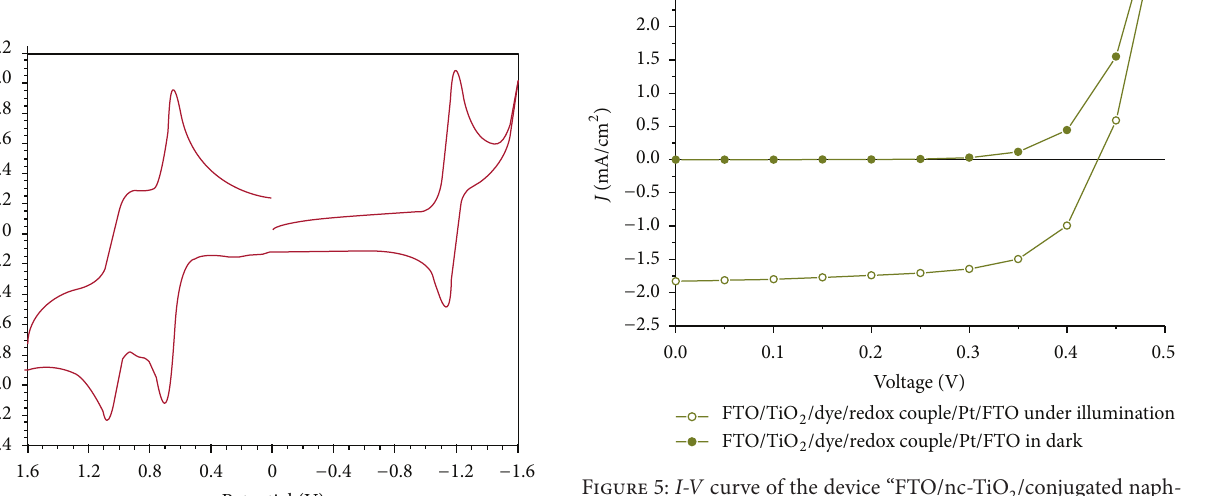
Table 1: 𝐸 EE-1 − 1.18 0.64 5.06 3.22